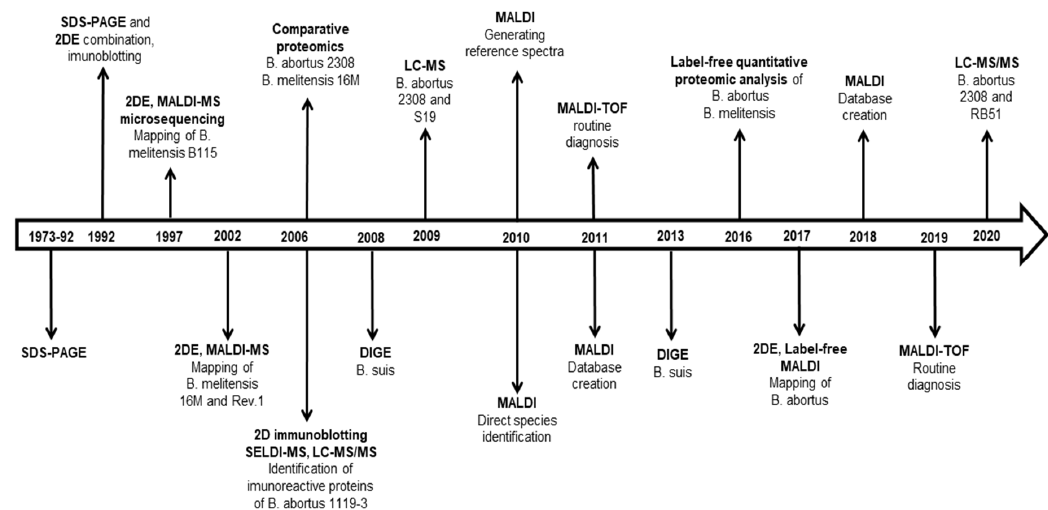
Figure 2. Chronological application of proteomics technology in Brucella research. SDS-PAGE (sodium dodecyl sulfate-polyacrylamide gel electrophoresis), 2DE (two-dimensional gel electrophoresis), DIGE (difference gel electrophoresis), SELDI-MS (Surface-enhanced laser